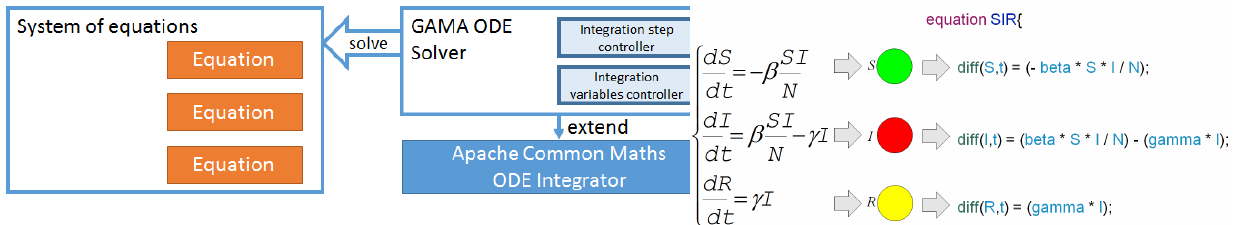
Figure 4. an ODE solver structure inside a modeling and simulation platform